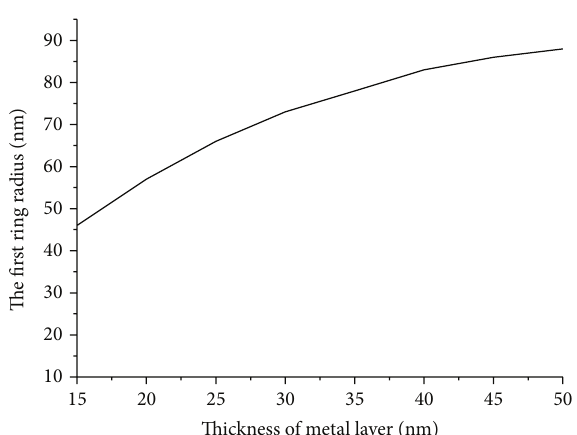
Figure 7: Dependence of the first ring radius of Bessel surface plasmon polariton on the thickness of Au layer embedded in ZrO 2 for high-index